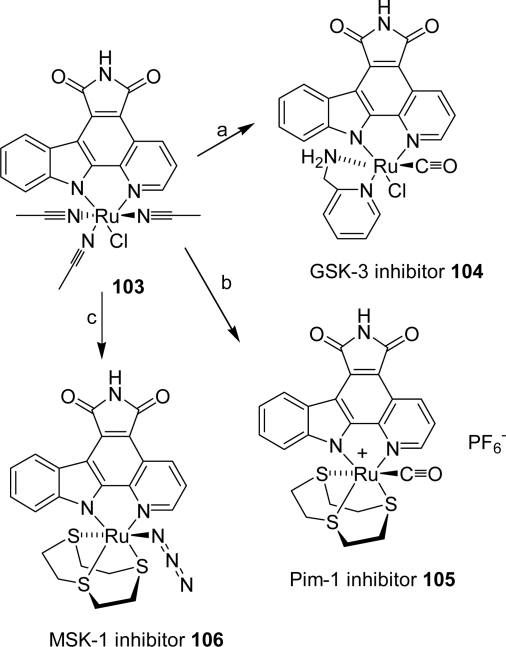
(a) CO-saturated DMF at 75 °C for 1.5 h then addition of 1 equiv of 2-aminomethylpyridine, 95 °C, 1 h. (b) (1) 1 equiv of 1,4,7-trithiacyclononane, DMF, 80 °C, 45 min (2) CO-saturated DMF, 95 °C, 2 h. (c) (1) 1 equiv of 1,4,7-trithiacyclononane, DMF, 80 °C, 1 h, (2) addition of 1 equiv of NaN3, 90 °C, 1 h.